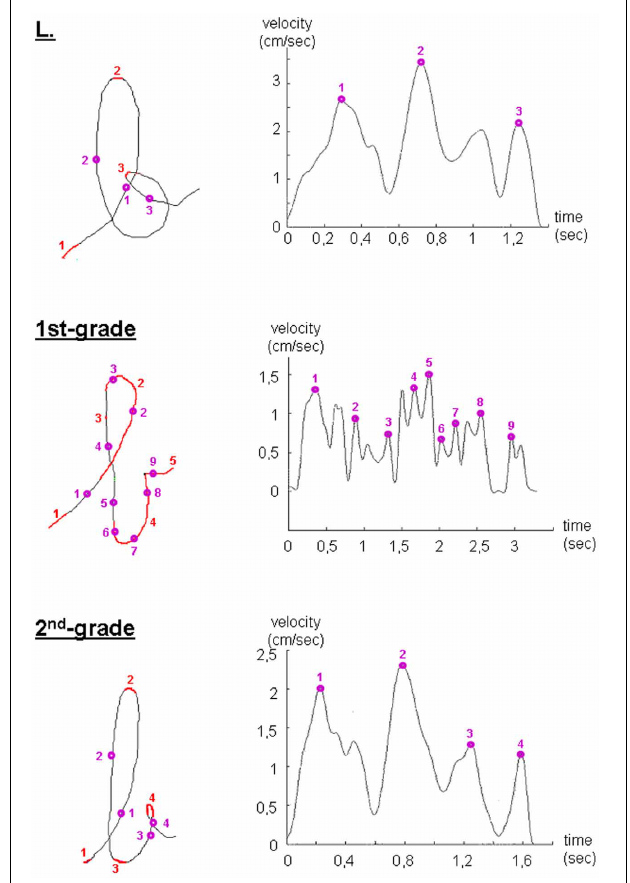
FIGURE 2 | Examples of the kinematic features of the letter “b” written by the child with DCD (L.) and a random first- and second-grader. The position of slow moves (red) and velocity peaks (purple circles) are shown on the letter tracks ( right panels ). On the left are shown the corresponding velocity profiles.